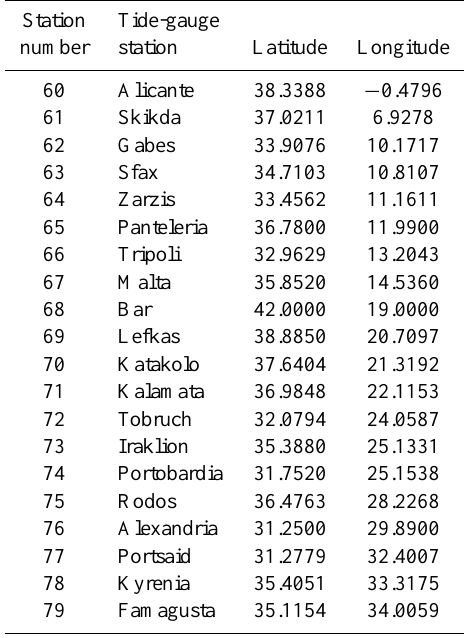
Table 2. Coordinates of the stations taken from Tsimplis et al. (1995).